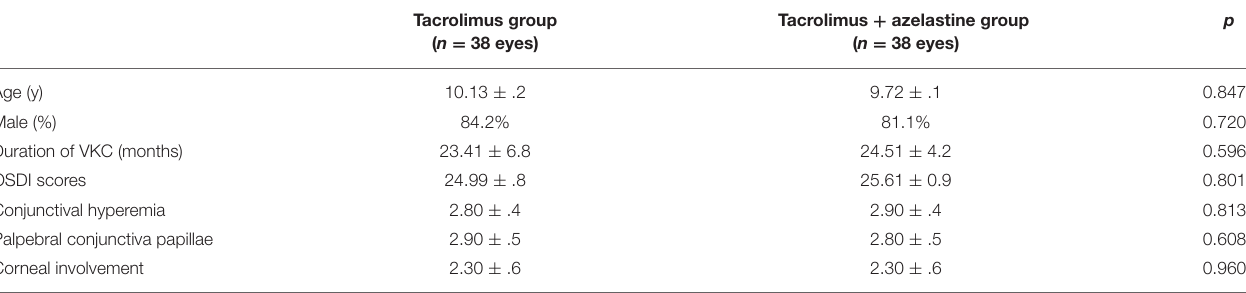
TABLE 1 | Patient demographic characteristics at baseline.